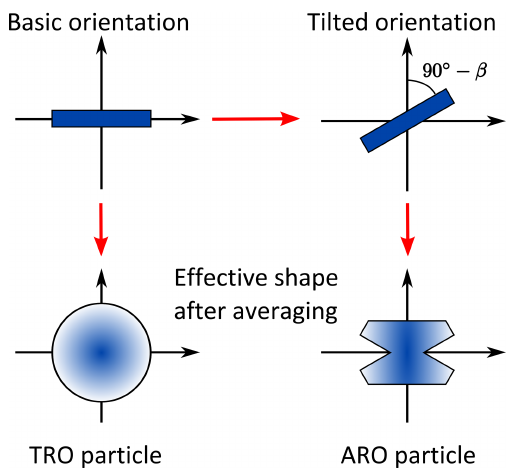
Figure 2. Schematic of the difference between totally random (TRO) and azimuthally random orientation (ARO) for columnar